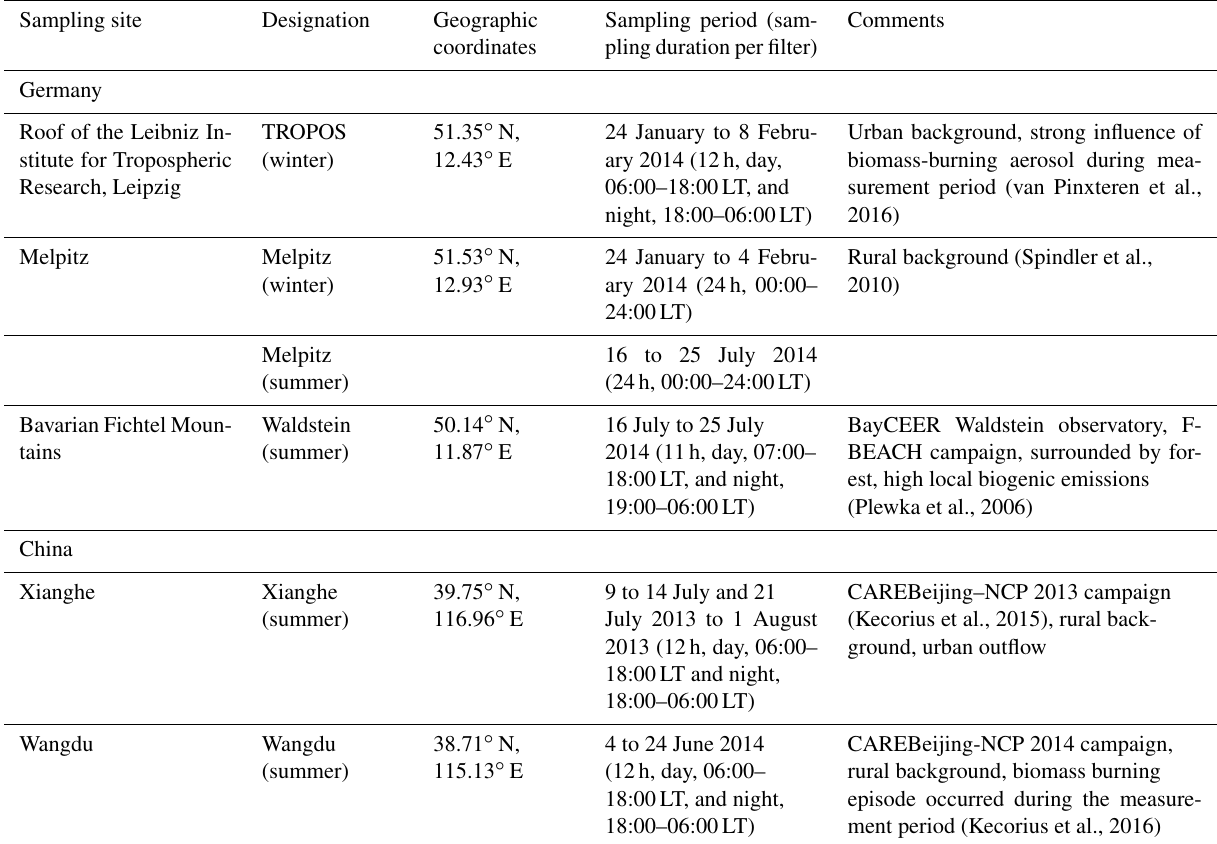
Table 1. Overview over sampling sites, used terminology, sampling period, sampling time given in local time (LT) and according atmospheric conditions during the sampling